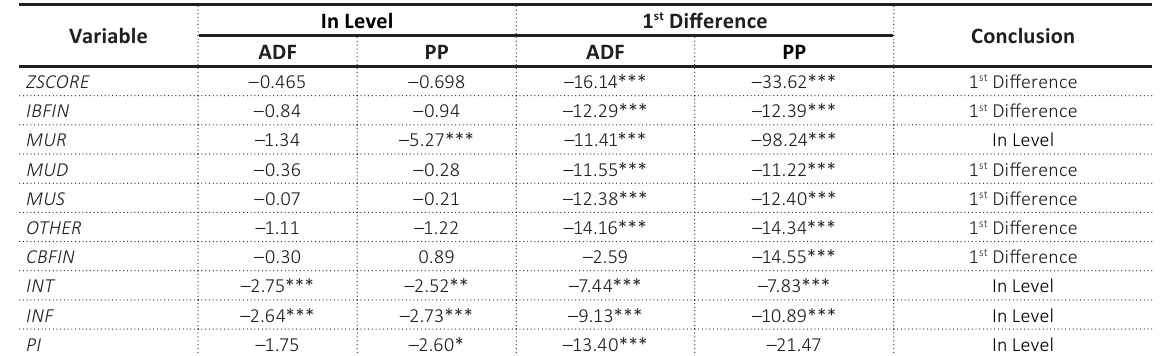
Table 3. Unit root test